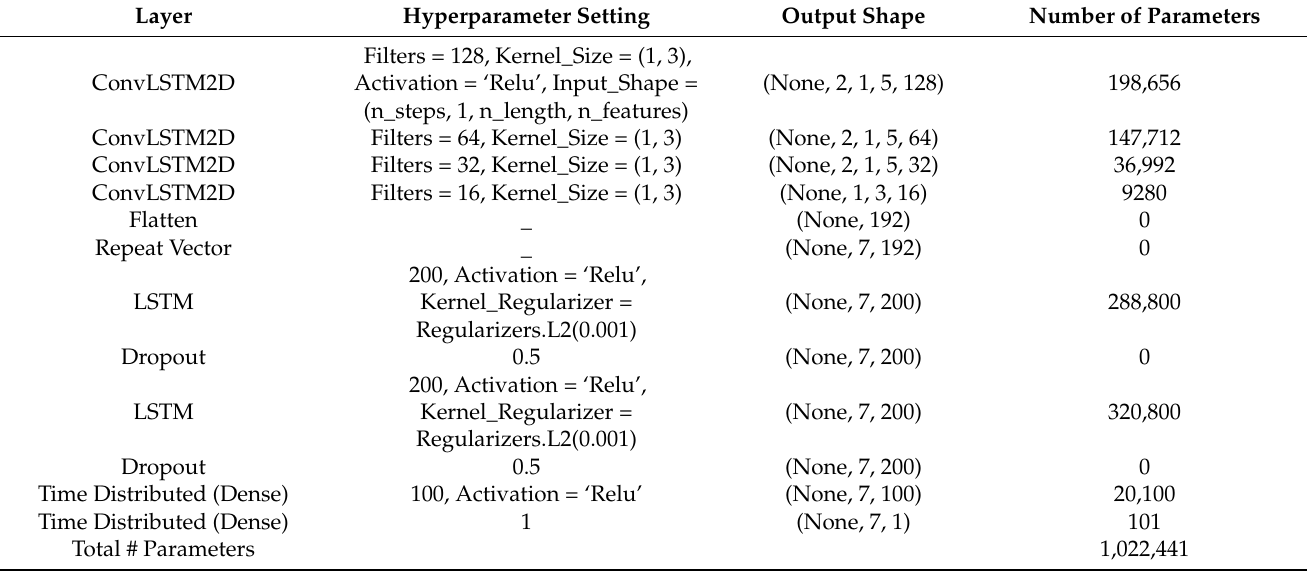
Table 2. Architecture of the proposed energy load forecasting